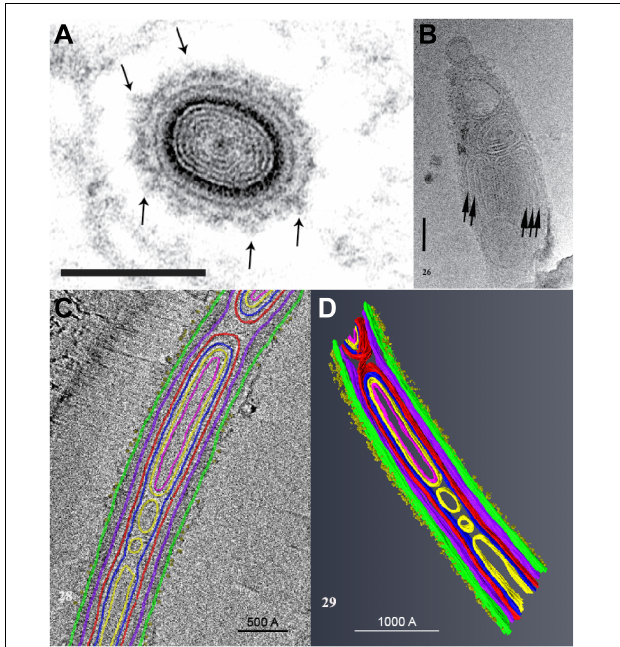
FIGURE 4 | An ultrastructural study of the extruded PT of Anncaliia algerae . (A) Light and transmission electron microscopy (TEM) showed the cross section of an extruded PT from spores. The lumen of the tube is filled with about eight alternating concentric thin ED and electron lucent (EL) rings of material. The outer wall of the PT is enclosed by a relatively thick ED wall which is in turn covered by additional rings of material. The outermost PT surface is a ring of medium dense fibrous material with tufts of fibers projecting outward (arrows). Bar is 100 nm. (B) CTEM of the distal end of PTs showed that end of the PT containing multiple tightly packed membranes (short arrows) that will give rise to the sporoplasm membrane “terminal sac.” Note the closed tip of the tube. Bar is 50 nm. (C) Tomogram of a portion of PT containing cargo and membranes, and its surface is covered with tufts of fibrillar material. The different PT structures are color coded to the various densities visible in the stacks of images and identified by color. (D) The tomogram was segmented and 3D models generated from it using Amira software. Reprinted with the permission of the publisher (Takvorian et al.,